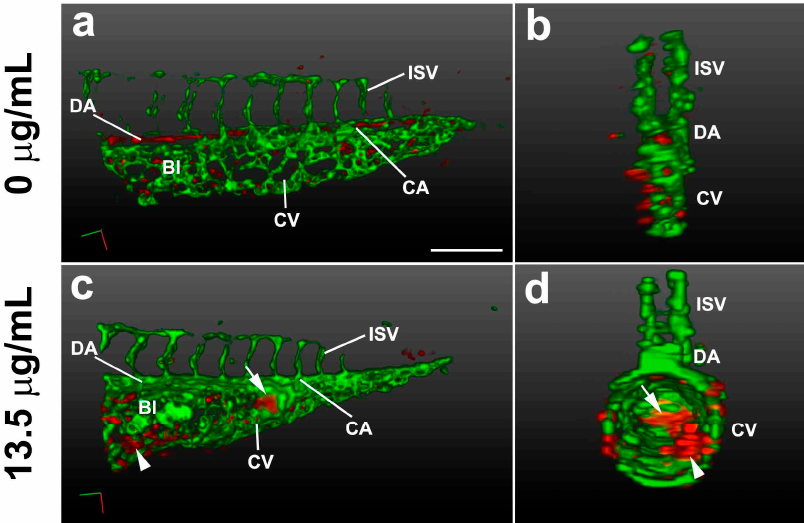
Figure 4. 3D light-sheet/SPIM imaging of the TNT circulation defect. The vasculature (green) and blood cells (red) of the posterior trunk were visualized in Tg(gata1:DsRed/fli1a:EGFP) embryos at 38 hpf. 3D reconstructions are shown at lateral view ( a , c ) and transverse view ( b , d ), using Arivis software (surface function). ( a , b ) Embryos treated for 33 h with control E3 media; ( c , d ) Embryos treated for 33 h with pink water containing 13.5 µg/mL TNT showing swollen body structure with abnormal blood islands (arrowhead) and blood accumulation (arrow). 20X water lens, 0.8 zoom. Scale bar, 150 µm. BI, blood Island; CA, caudal artery; CV, caudal vein; DA, dorsal aorta; ISV, intersegmental vessel. The 3D movies of the reconstructions are presented in Supplementary video 2A,B.